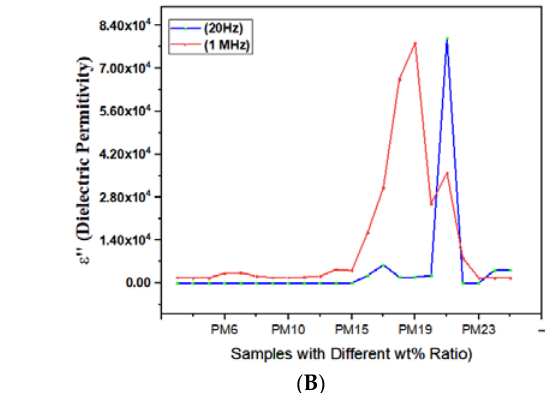
Figure 7. Variation in dielectric constant ε′ ( A ) and dielectric permittivity ε″ ( B ) of different polymer nano composite films at frequencies 20 Hz and 1 MHz.